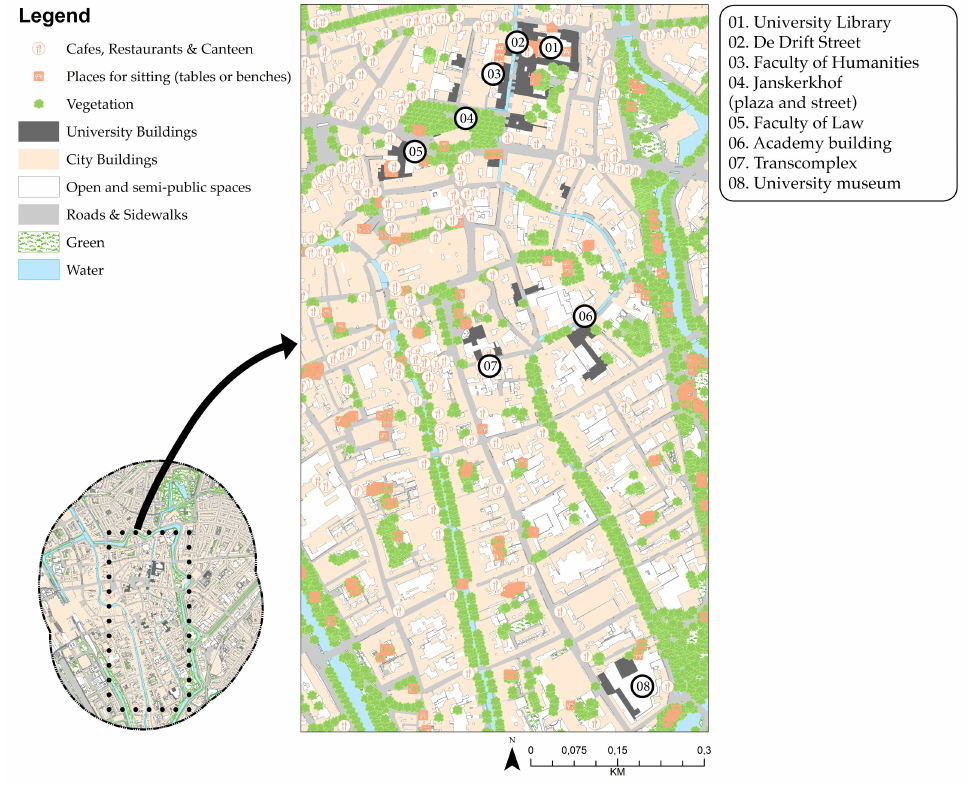
Figure 6. Utrecht inner-city